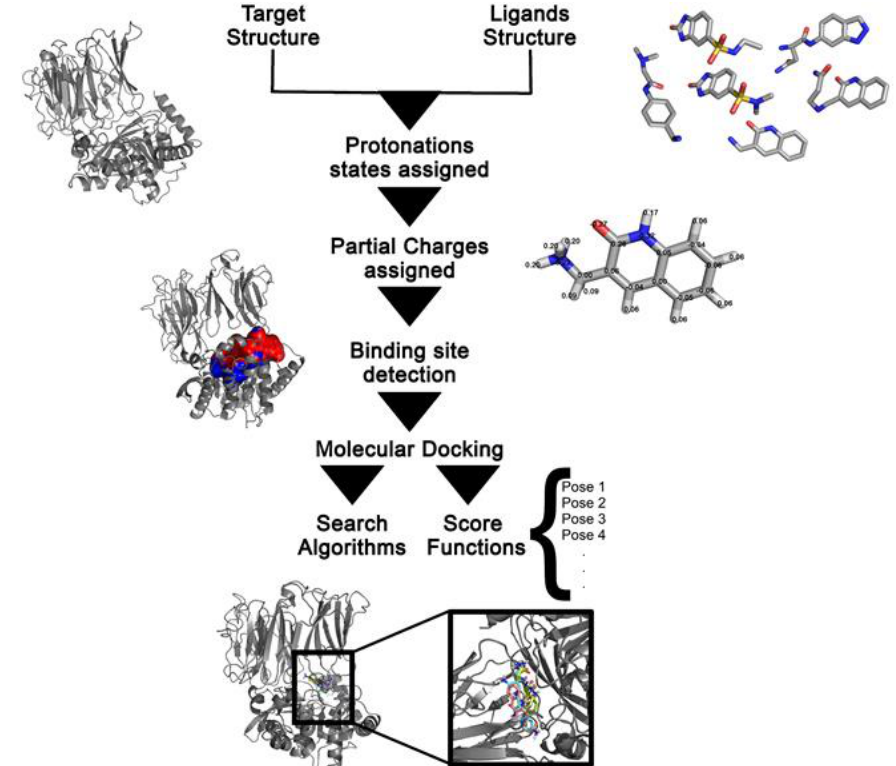
Figure 1. General workflow of molecular docking calculations. The approaches normally start by obtaining 3D structures of target and ligands. Then, protonation states and partial charges are assigned. If not previously known, the target binding site is detected, or a blind docking simulation may be performed. Molecular docking calculations are carried out in two main steps: posing and scoring, thus generating a ranked list of possible complexes between target and ligands.